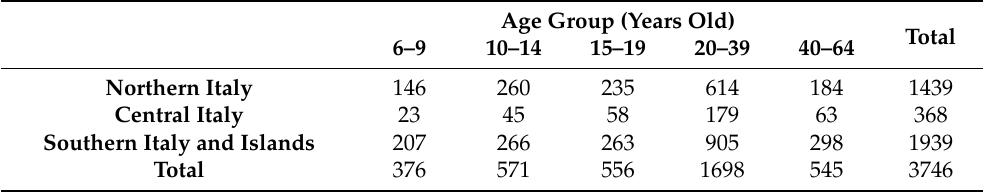
Table 2. Distribution of samples stratified by geographical area and age